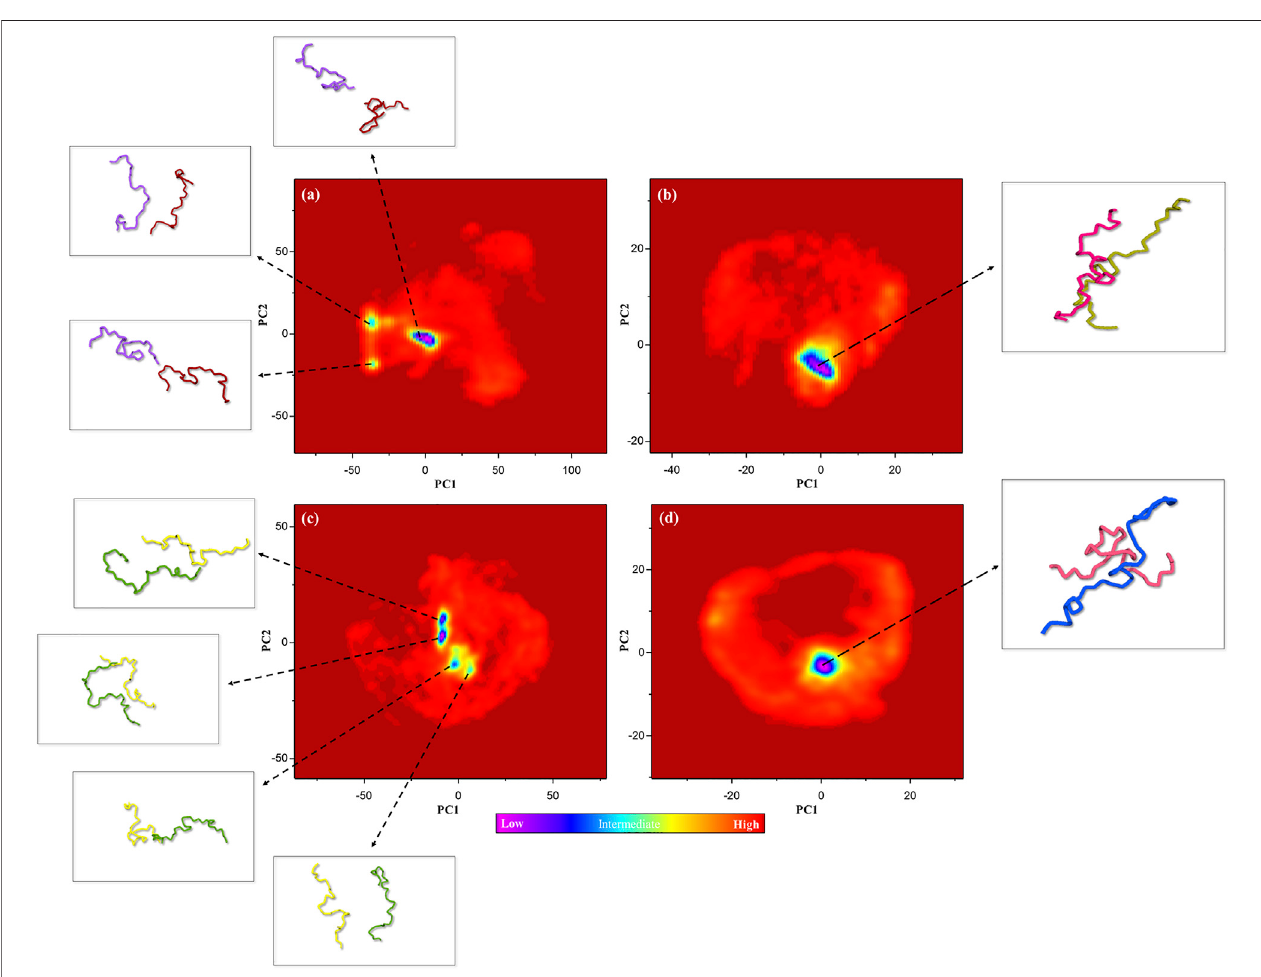
FIGURE 6 | Free energy landscape (FEL) of the control (non-phosphorylated tau), positive control ( Δ 280-tau), and the complexes with one (P-Ser262) and three (P-Ser262, 285, and 289) phosphorylated sites on principalcomponents 1and 2during 200 ns simulations. Multiple minimum-energy clusterswere observed in (A) the control and (C) P-Ser262, but one cluster was observed in (B) the positive control and (D) P-Ser262, 285, 289.